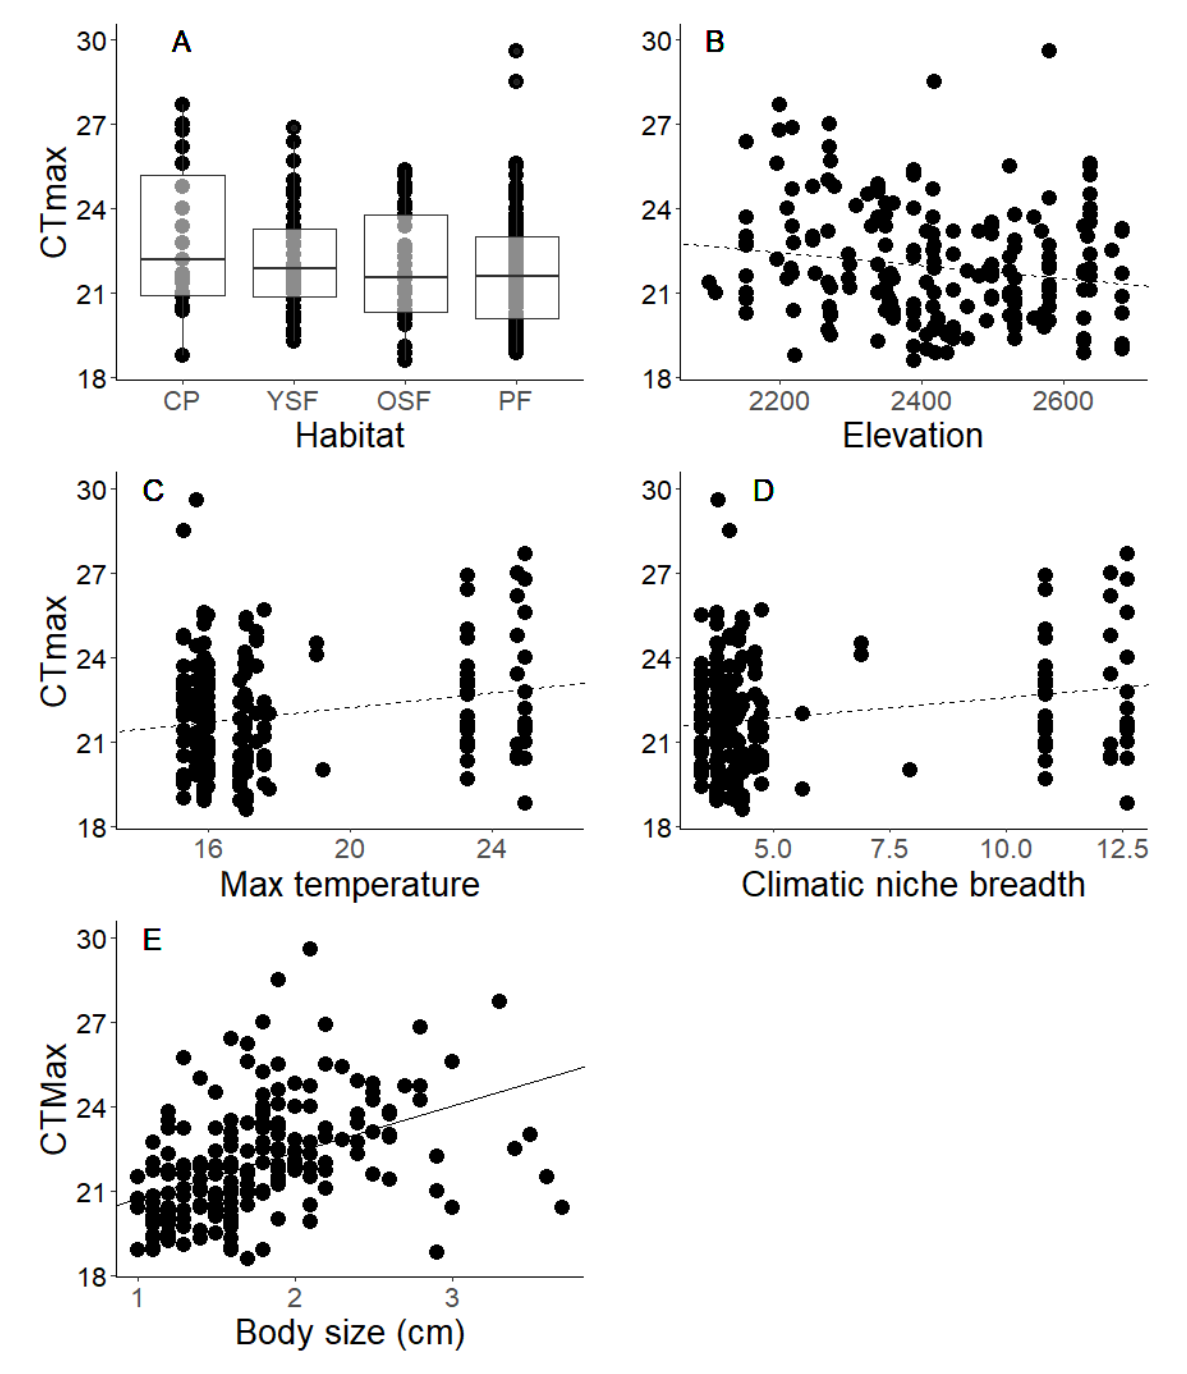
Figure 3. Relationship between Pristimantis frogs’ CT max and ( A ) habitat (CP: cattle pasture; YSF: Young secondary forests; OSF: Old secondary forests; PF: Primary forests), ( B ) elevation, ( C ) maxi- mum temperature, ( D ) climatic niche breadth, and ( E ) body size (snout-vent length). Solid lines represent significant relationships ( p < 0.05).